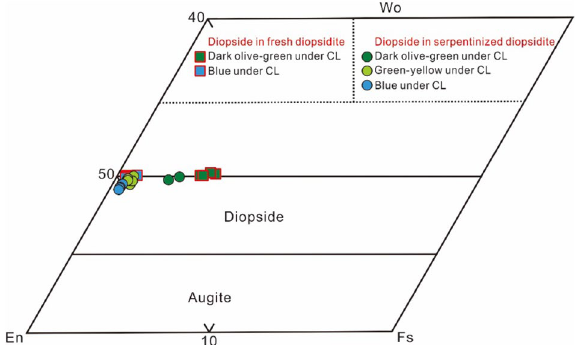
Figure 8. Mineral compositions of the pyroxenes in the Yushishan diopsidites. The CaSiO 3 (Wo)–MgSiO 3 (En)– FeSiO 3 (Fs) diagram (modified from Morimoto et al. 48 ) shows that all pyroxenes are